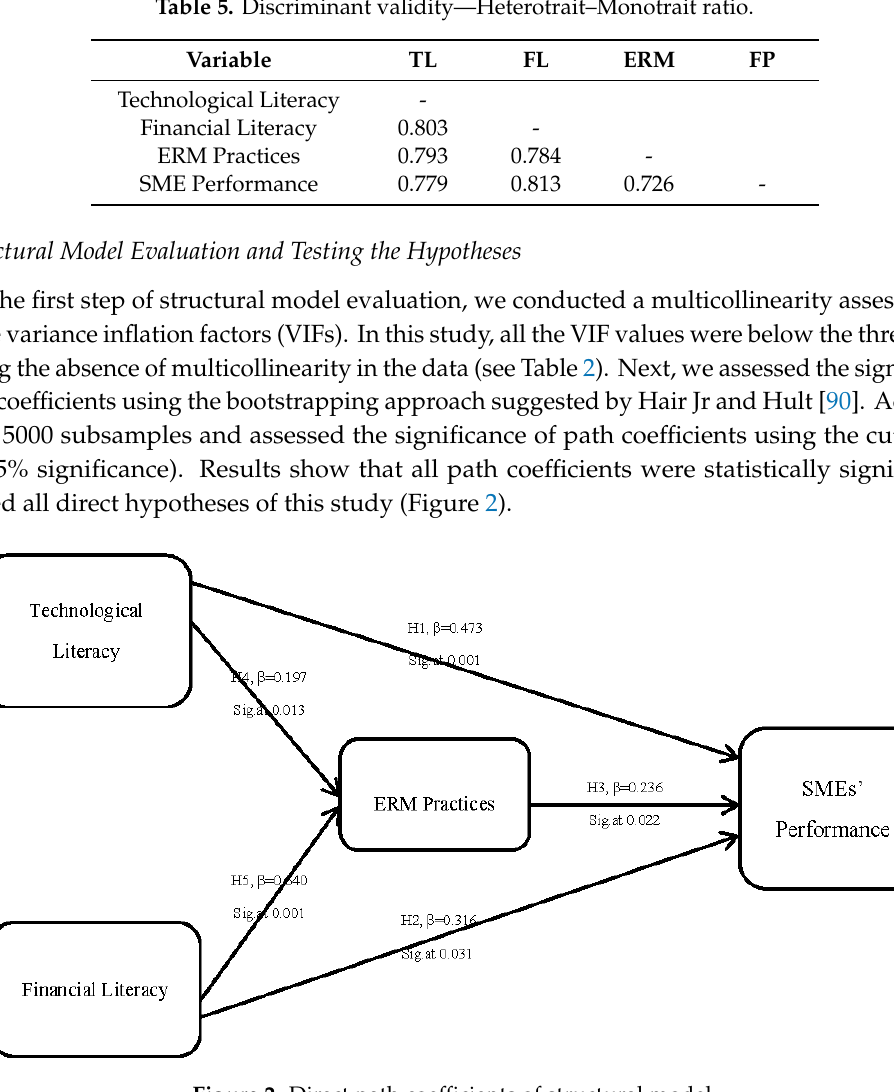
Figure 2. Direct path coefficients of structural model.